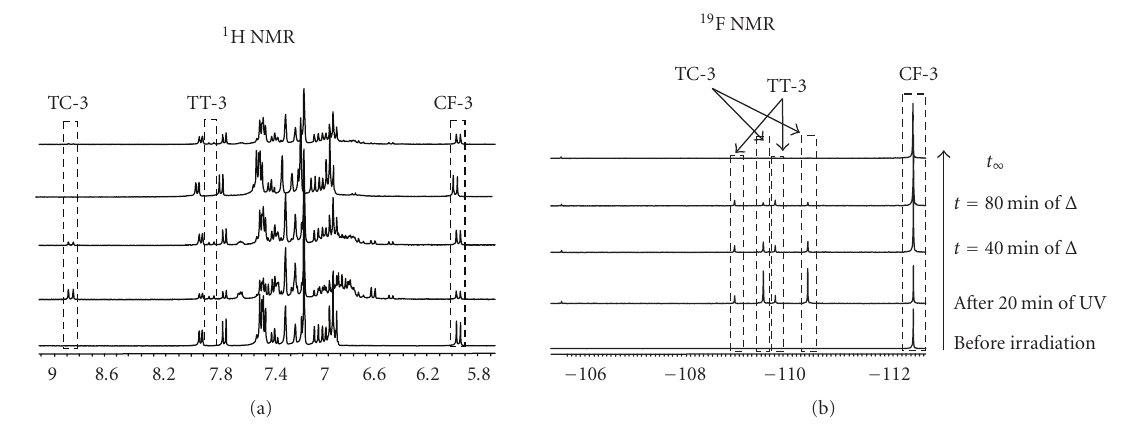
Figure 1: 1 H and 19 F NMR spectra of CF-1 in toluene at 223 K.